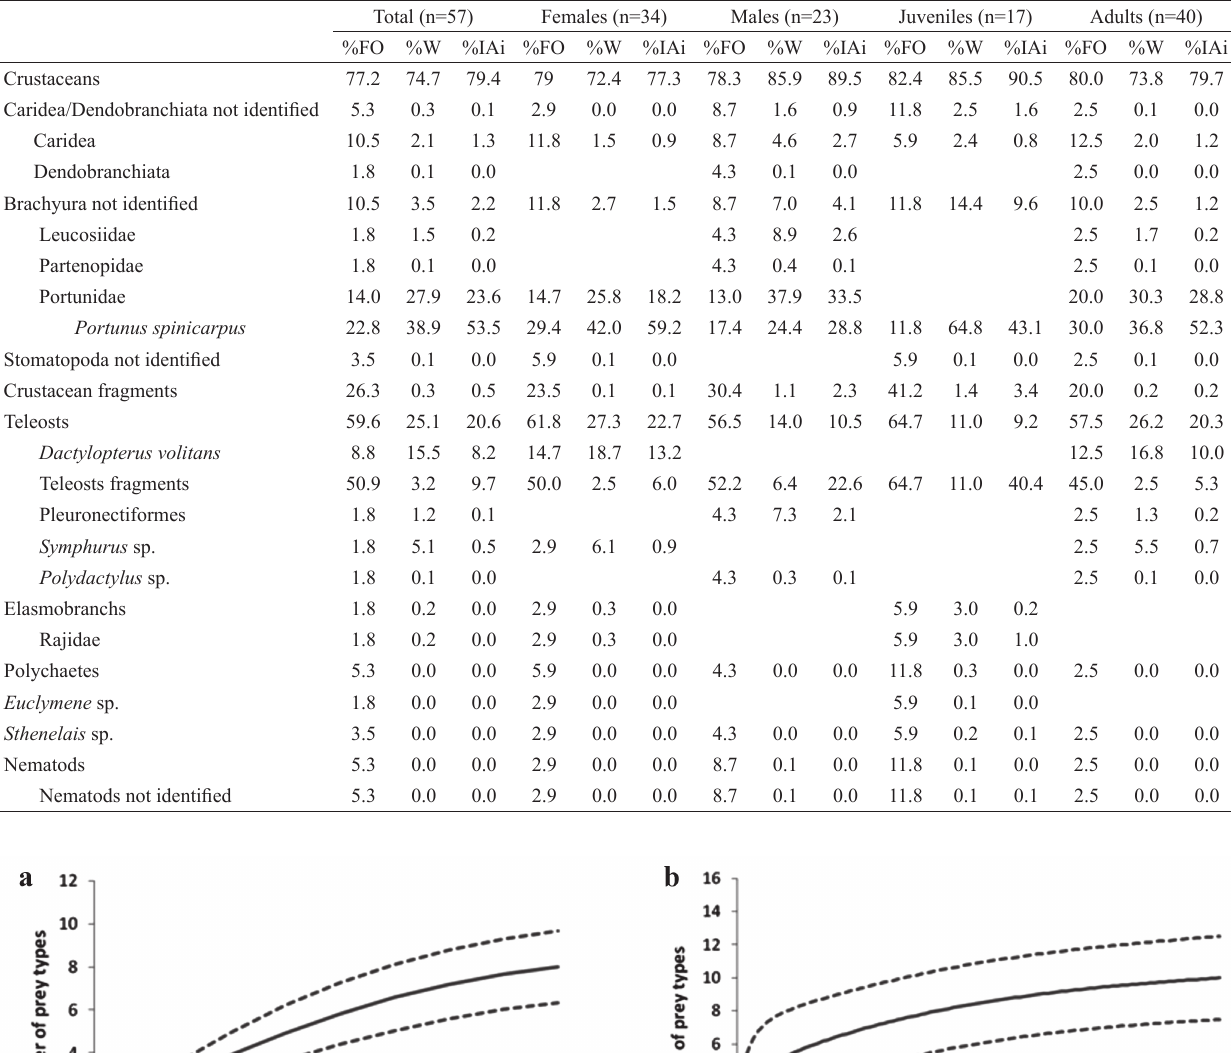
Tab. 1. Frequency of occurrence (%FO), percentage weight (%W) and alimentary index (%IAi) of prey items in the total diet of Atlantoraja cyclophora in southeastern Brazil, between January 2006 and August 2007. Published by Viana, Vianna (2014).